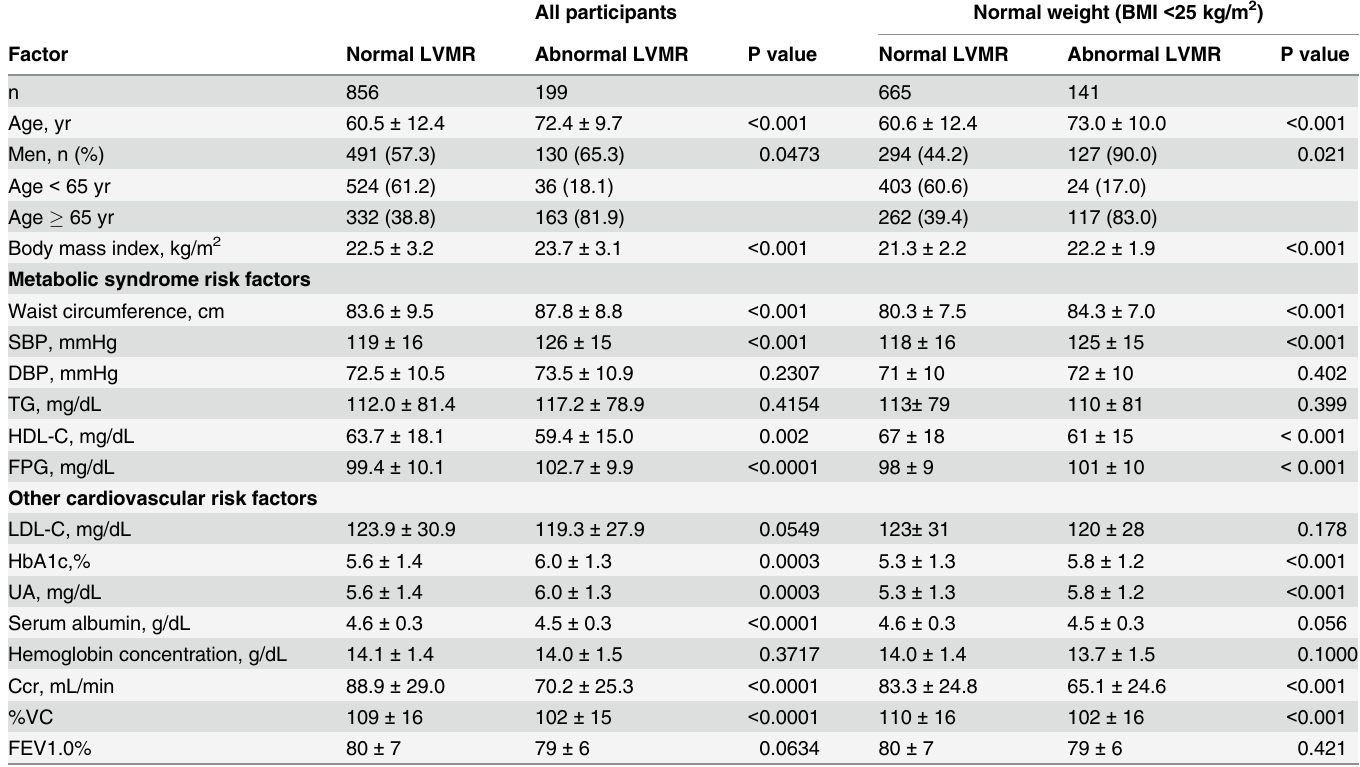
Table 3. Predictors of abnormal